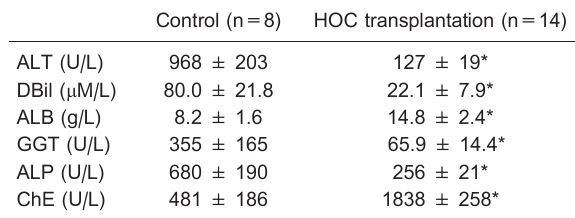
Table 1. Quantification of the mRNA expression of ALB and CK19 by RT-PCR.